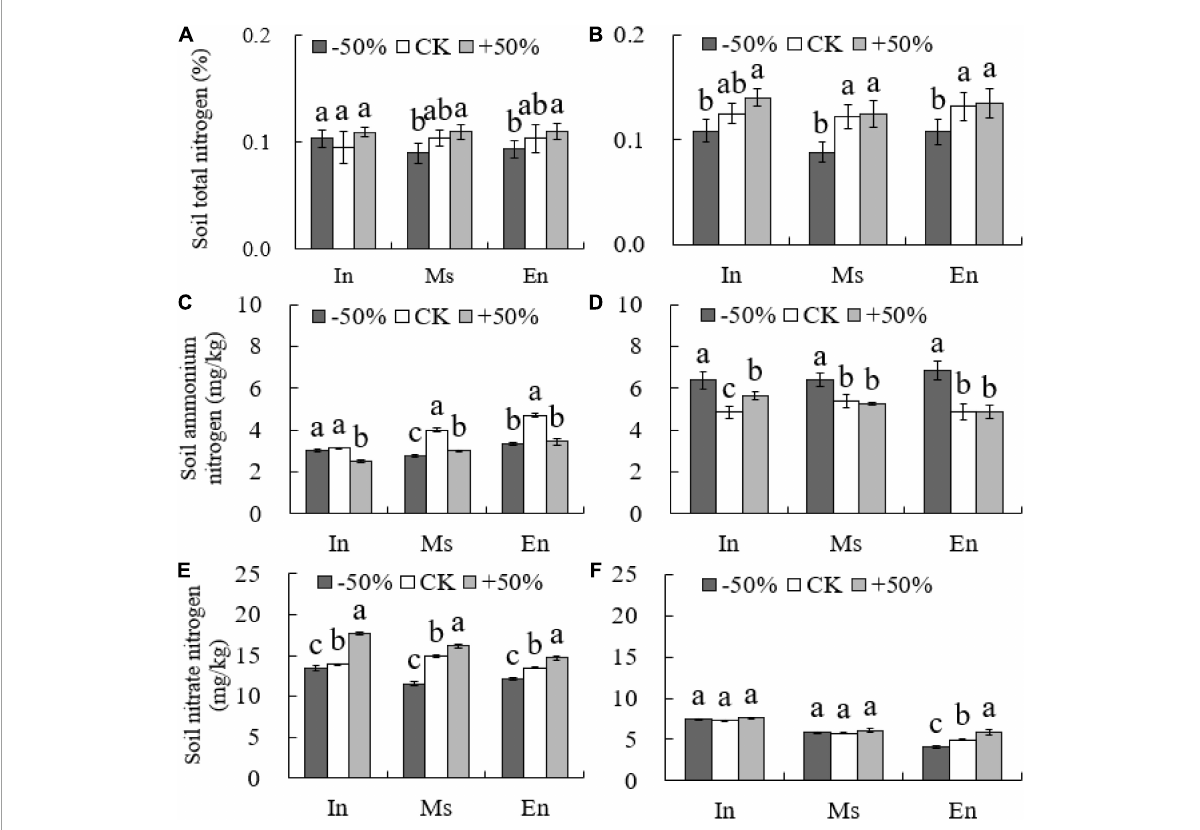
FIGURE3 Soil nitrogen content under different water conditions ( A,C,E : 2015; B,D,F : 2016). Different lowercase letters show significant differences under different water levels ( P < 0.05).